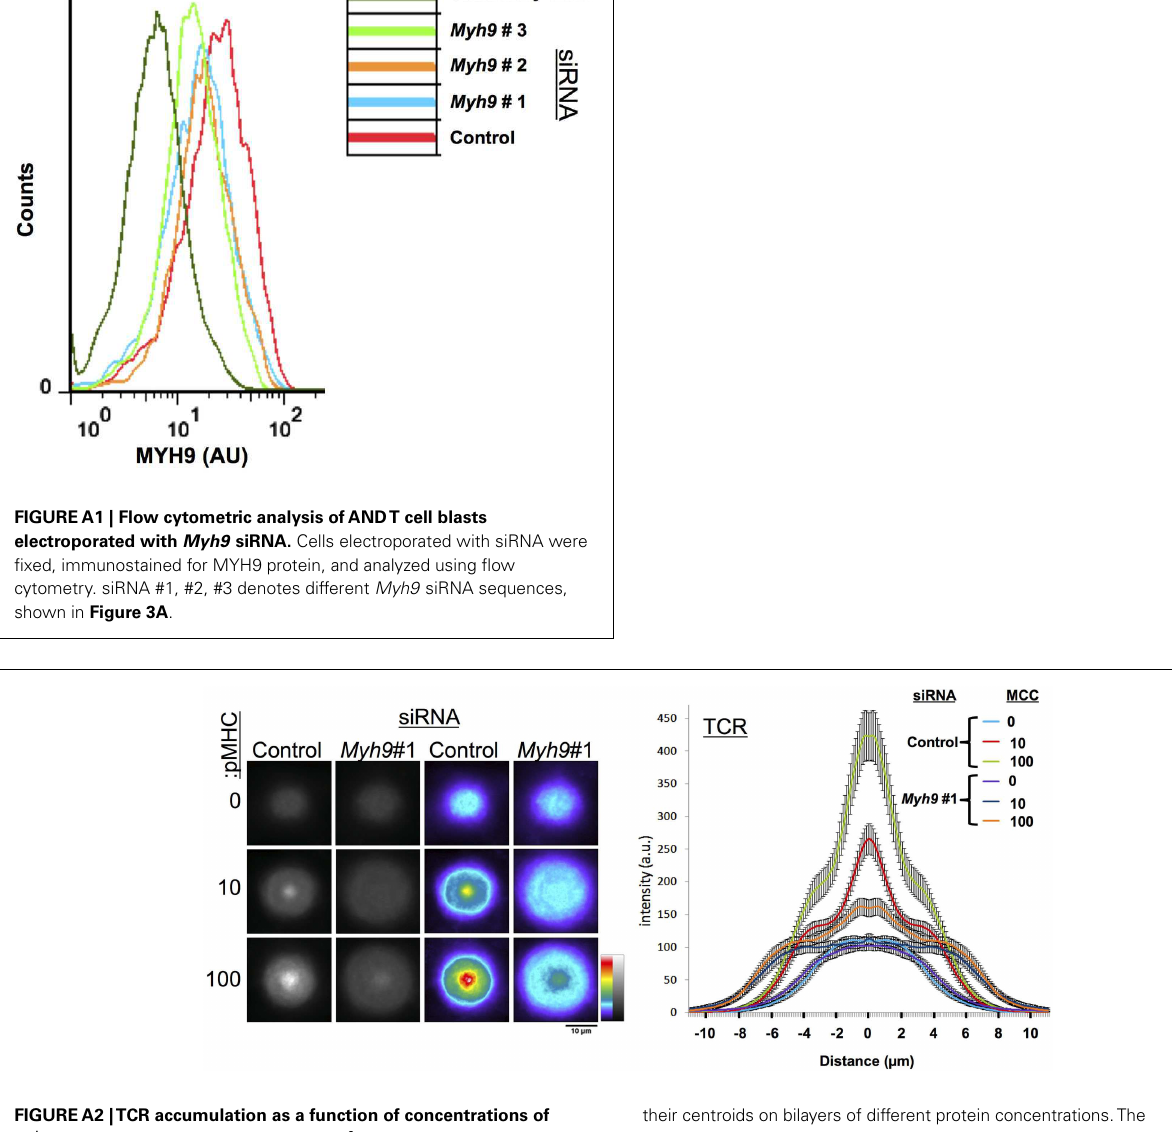
FIGUREA2 |TCR accumulation as a function of concentrations of I-E k -MCC at 0, 10, and 100molecules/ µ m 2 in the substrate bilayer with 200molecules/ µ m 2 ICAM-1. Left panel shows averages of 60 or more cells treated with Myh9 #1 or control siRNA registered at